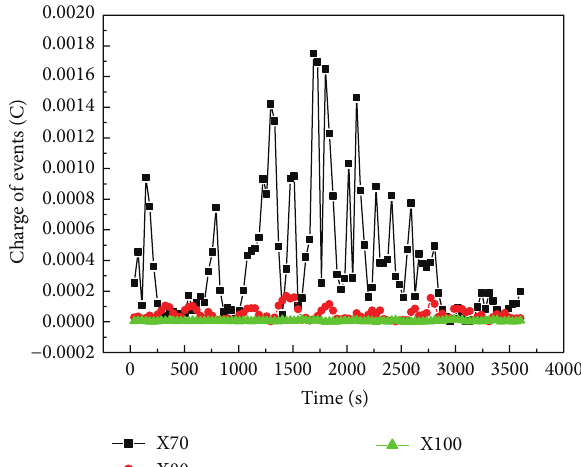
Figure 9: Cumulative probability plots of passive films formed on X70, X80, and X100 pipeline steels for the frequency of events, 𝑓 𝑛 .